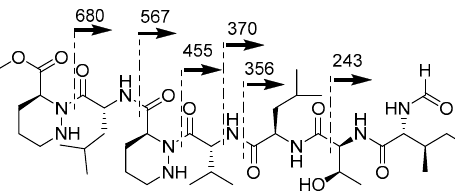
Figure 3. MS/MS fragmentation of the methanolysis product ( 3 ) of 1 .